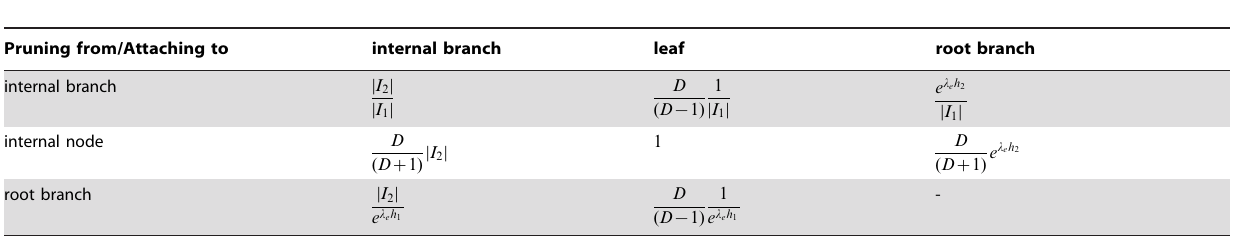
Pruning from/Attaching